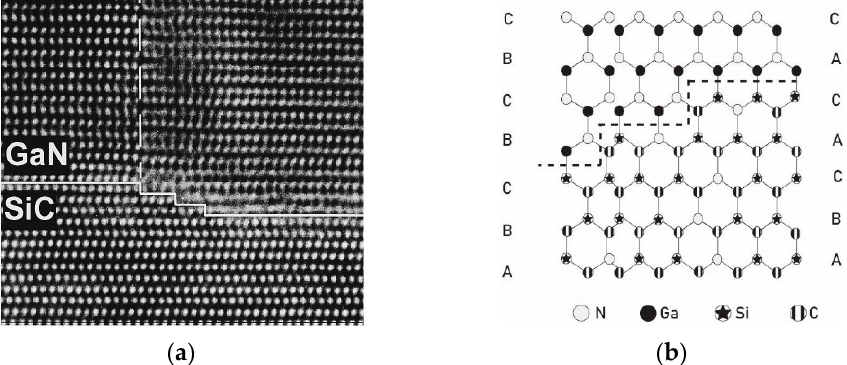
Figure 6. The formation of threading defects in the epi-layer by the substrate steps [45]. ( a ) High- resolution TEM (HRTEM) characterization of defects at the interface. ( b ) Atomistic model of mismatch boundary resulting from interfacial steps at the substrate.